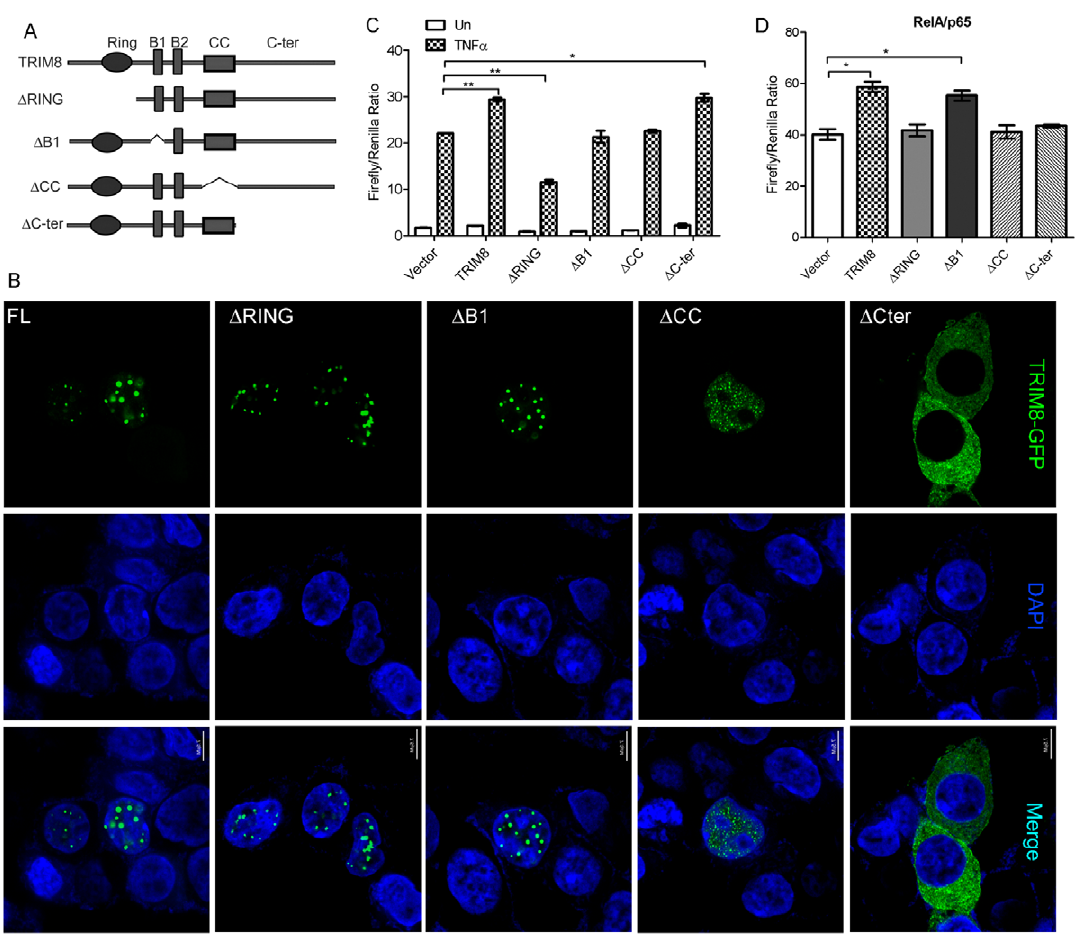
Figure 2. Cellular localization of different domains of TRIM8 and their role in NF- k B activation. (A) Schematic diagram showing TRIM8 domains and constructs used for transfection. (B) Cellular localization of TRIM8 deletion constructs. HeLa cells were plated on cover slip and transfected with GFP-tagged different deletion constructs of TRIM8. After 24 hours of transfection, the cells were fixed with 4% paraformaldehyde, stained with DAPI and visualized by confocal microscopy. Scale bar represent 7.5 m M. (C) RING domain is essential for positive regulation of TNF induced NF- k B activation. HEK293 was co-transfected with full length TRIM8, D RING, D B1, D CC, D C-ter, vector, treated with TNF a and NF- k B activation measured by Dual Glo luciferase assay. (D) RING, CC domain and C-terminal region of TRIM8 is essential for p65 mediated NF- k B activity. HEK293 was co-transfected with full length TRIM8, D RING, D B1, D CC, D C-ter, vector with p65-GFP and NF- k B activation measured by Dual Glo luciferase assay. Asterisk (*) indicates NF- k B activation significantly changed between groups: p value , 0.05 for SEM of minimum three independent experiments.